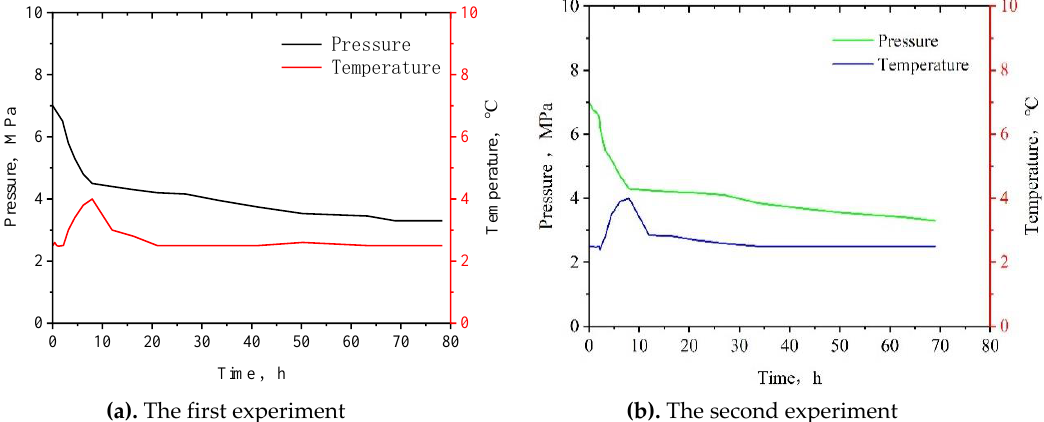
Figure 8. Temperature and pressure changes during preparation of hydrate in spray method.